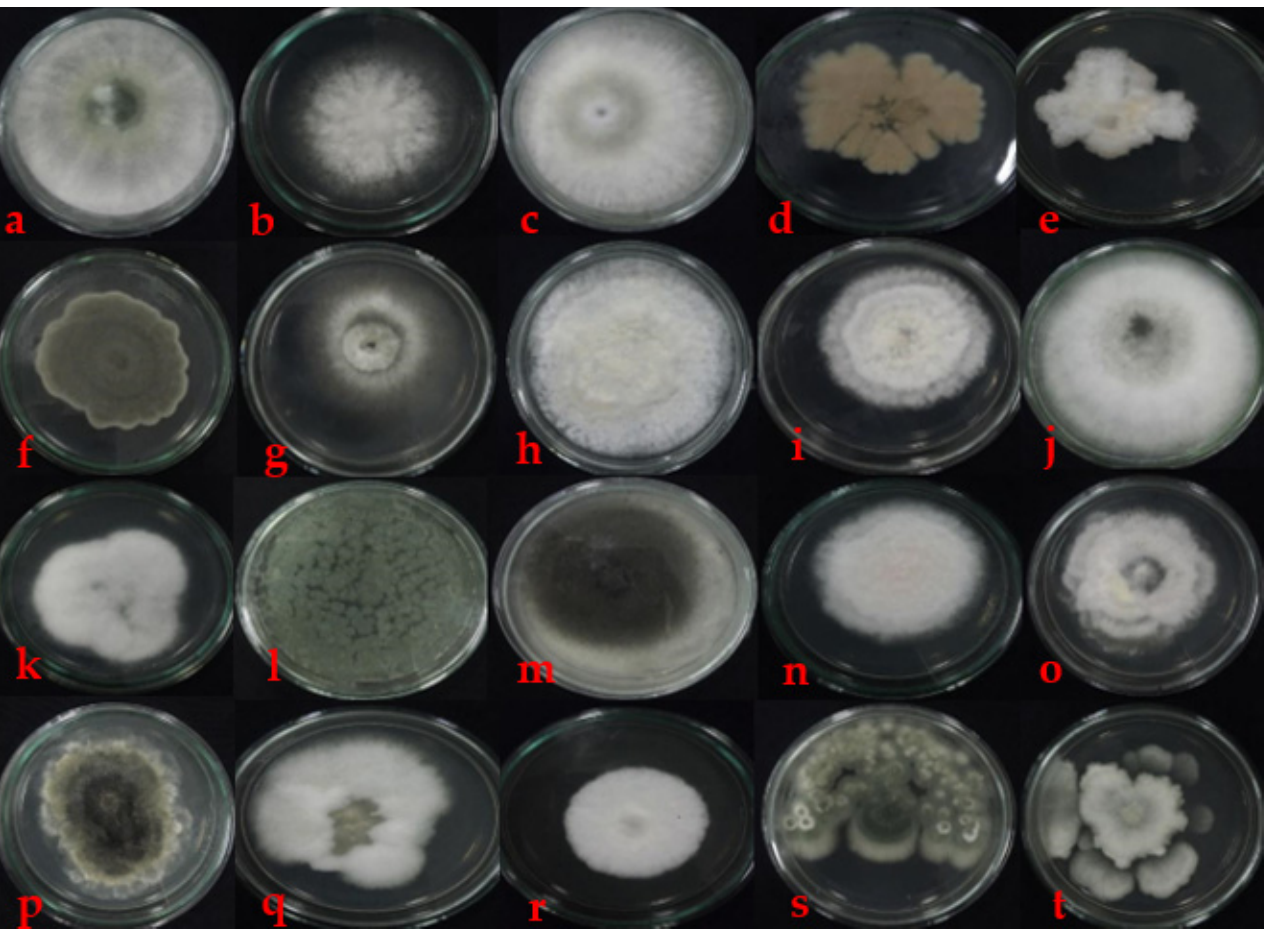
Figure 2. Colonies of Phylloplane Fungi ( a ) Trichoderma harzianum strain QTYC64; ( b ) Nigrospora sphaerica ; ( c ) Lasiodiplodia theobromae ; ( d ) Scopulariopsis brevicaulis ; ( e ) Unidentified; ( f ) Curvularia clavata ; ( g ) Fusarium solani ; ( h ) Unidentified; ( i ) Neopestalotiopsis clavispora ; ( j ) Nigrospora sp.; ( k ) Fusarium oxysporum ; ( l ) Aspergillus versicolor ; ( m ) Nigrospora singularis ; ( n ) Nigrospora sp. JS24; ( o ) Pestalotiopsis microspora ; ( p ) Pestalotiopsis sp.; ( q ) Fusarium incarnatum; ( r ) Myrothecium sp.; ( s ) Penicillium oxalicum ; ( t ) Trichoderma harzianum strain WJF52.